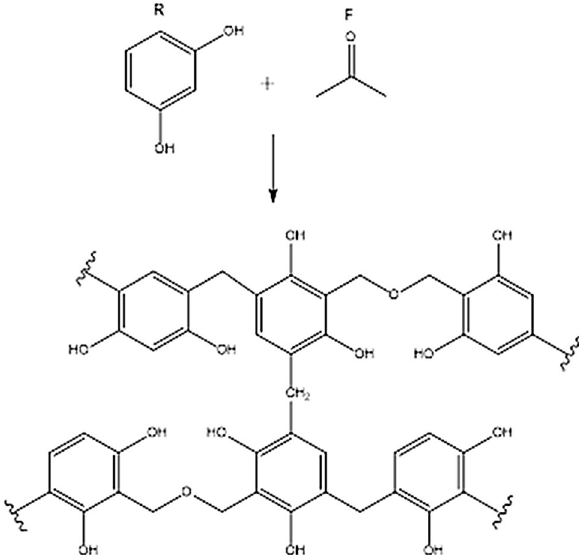
Figure 2. A suitable pathway for polymerization of formaldehyde and resorcinol.